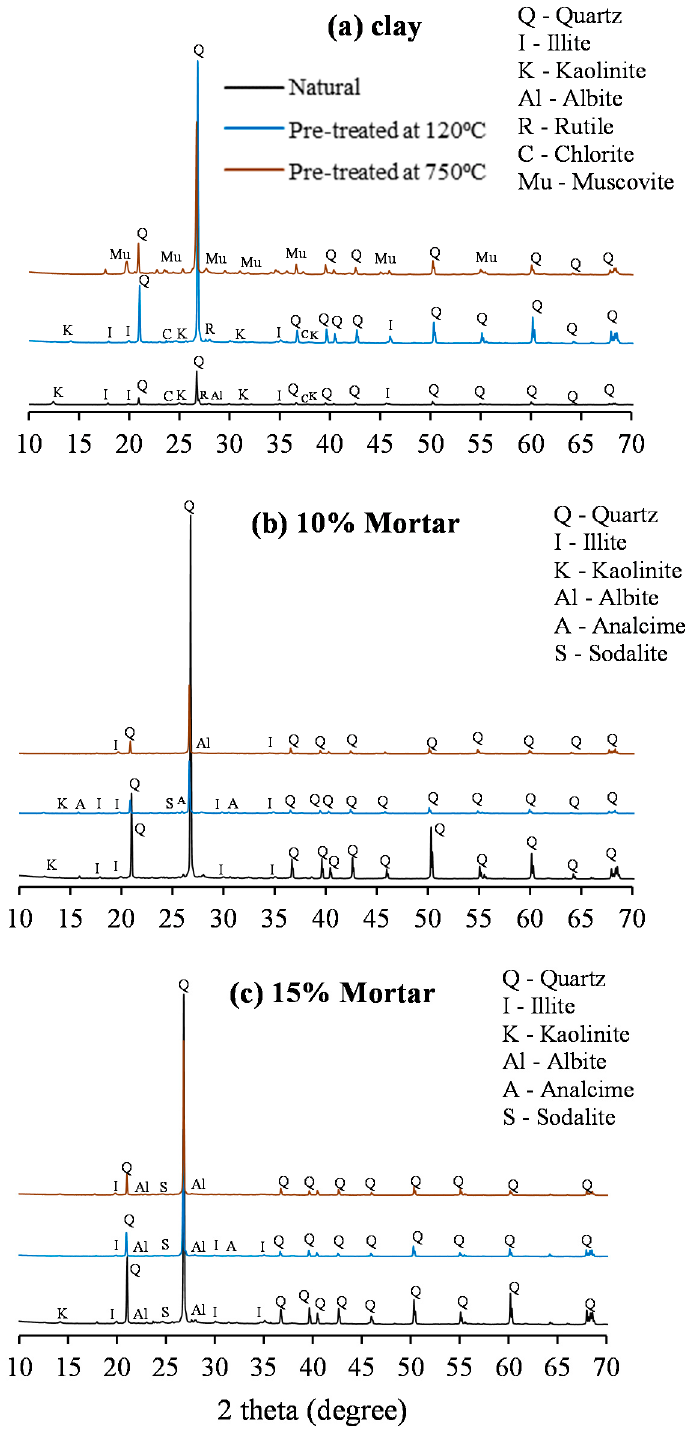
Figure 3. XRD spectra: ( a ) clay, ( b ) 10% mortar, and ( c ) 15% mortar.